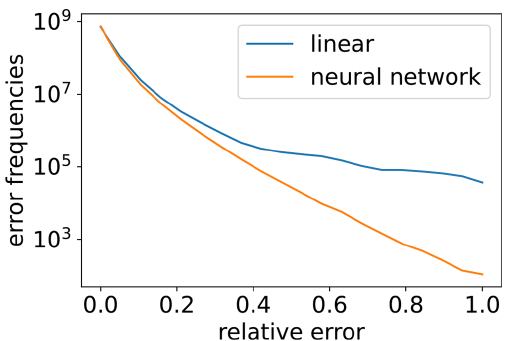
Figure 4. Comparison of the error frequencies for linear and neural network interpolation ( model2 ) for 14 January 2000 (over all 137 vertical levels and over 24h). Here, we normalized the error and split the error frequencies into 20 bins of different